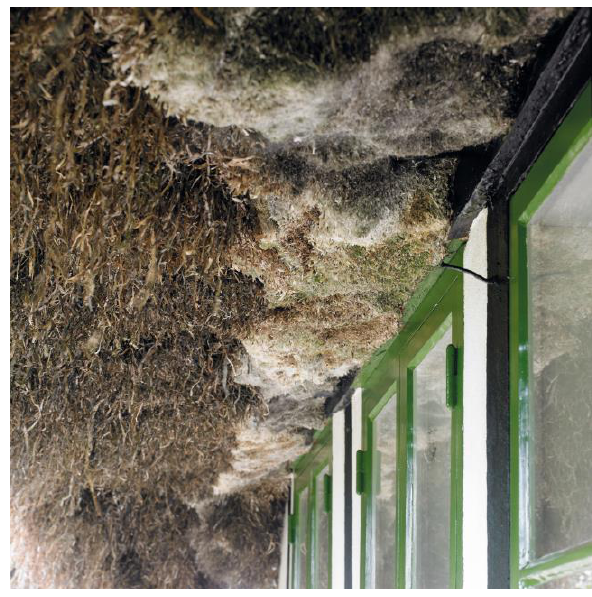
Figure 5. Older layers of seaweed has been preserved (Photo- grapher Helene Høyer Mikkelsen / Realdania By &